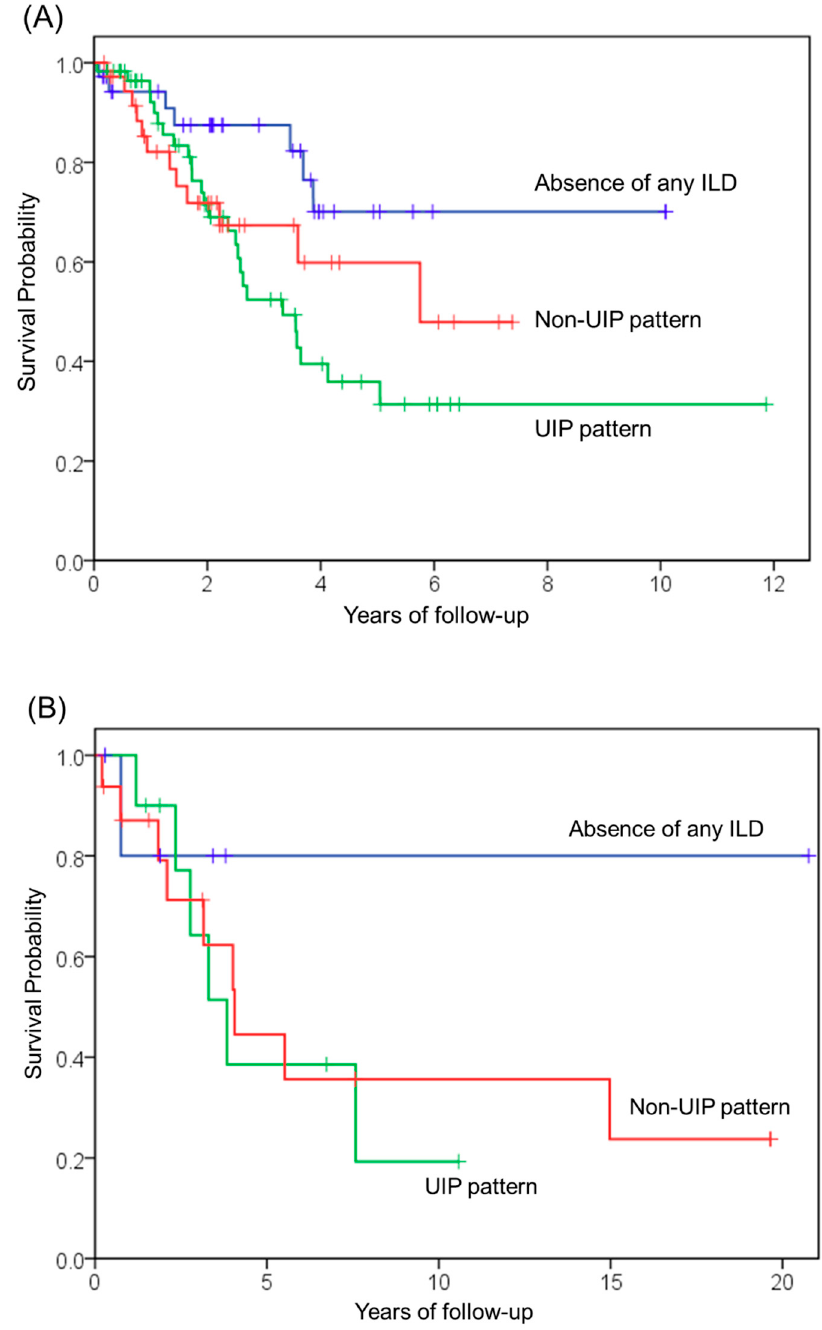
Figure 4. Subgroup survival analyses of patients with PPFE. Survival durations were estimated and compared using the Kaplan–Meier method and log-rank test, respectively. ( A ) Idiopathic PPFE patients were divided into three groups based on the following: (1) The presence of UIP pattern; (2) the presence of non-UIP pattern; (3) the absence of any ILD pattern in the lower lobes. Absence of any ILD versus non-UIP pattern ( p = 0.16); absence of any ILD versus UIP pattern ( p = 0.01); non-UIP pattern versus UIP pattern ( p = 0.42). ( B ) Secondary PPFE patients were divided into three groups based on the following: (1) The presence of UIP pattern; (2) the presence of non-UIP pattern; (3) the absence of ILD pattern in the lower lobes. There were no statistical differences between the groups. Absence of any ILD versus non-UIP pattern ( p = 0.33); absence of any ILD versus UIP pattern ( p = 0.34); non-UIP pattern versus UIP pattern ( p = 0.78).